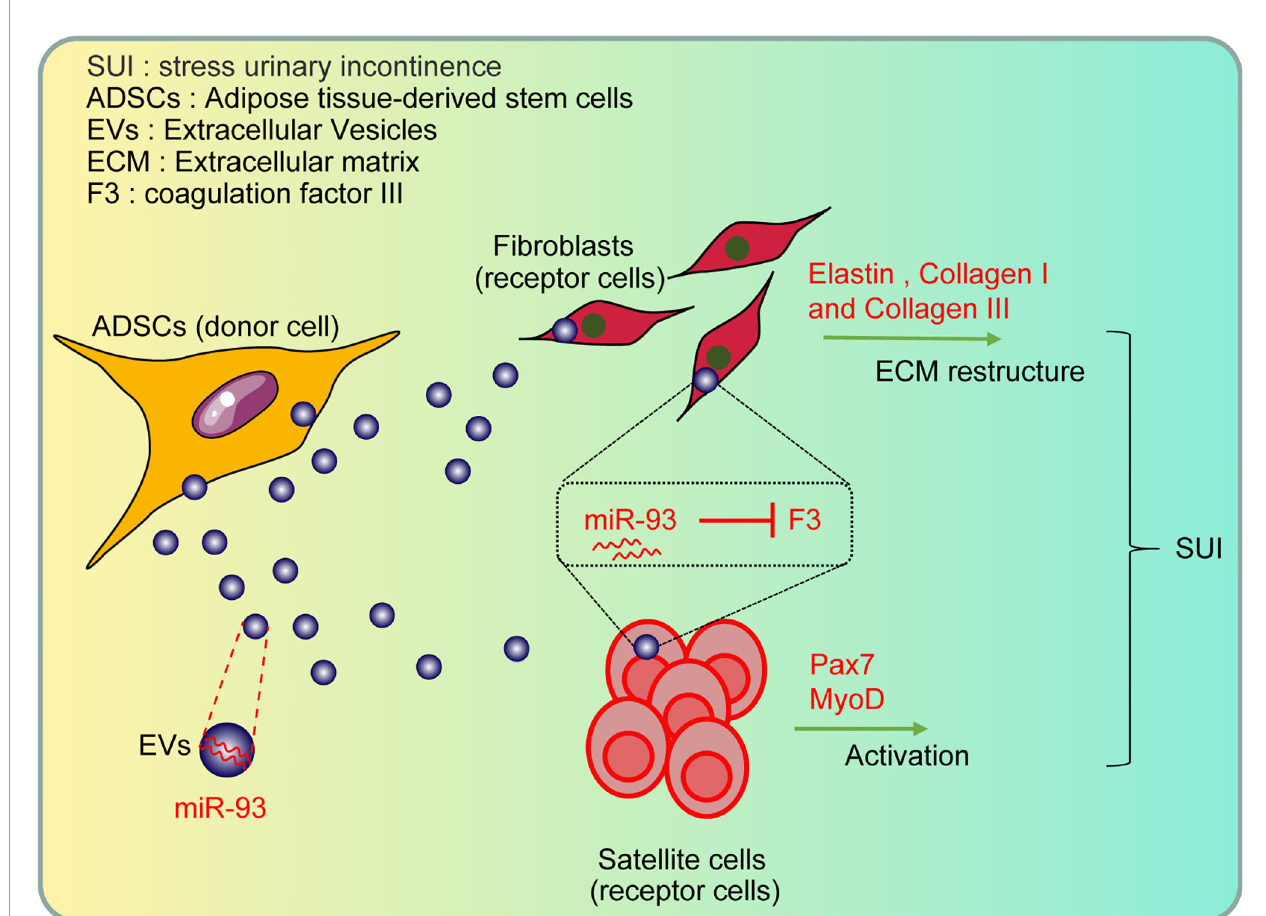
FIGURE 7 | The role and mechanism of miR-93 delivered by ADSCs-EVs in the treatment of SUI in vitro through regulating the target gene F3: the ADSCs-EVs can be endocytosed by fi broblasts and SCs, and then the carried miR-93 can enter the recipient cells to upregulate the expression of miR-93 in cells, inhibit the expression of F3 (target gene of miR-93), and then regulate the ECM remodeling of fi broblasts and the activation of SCs, playing a role in the treatment of SUI in vitro